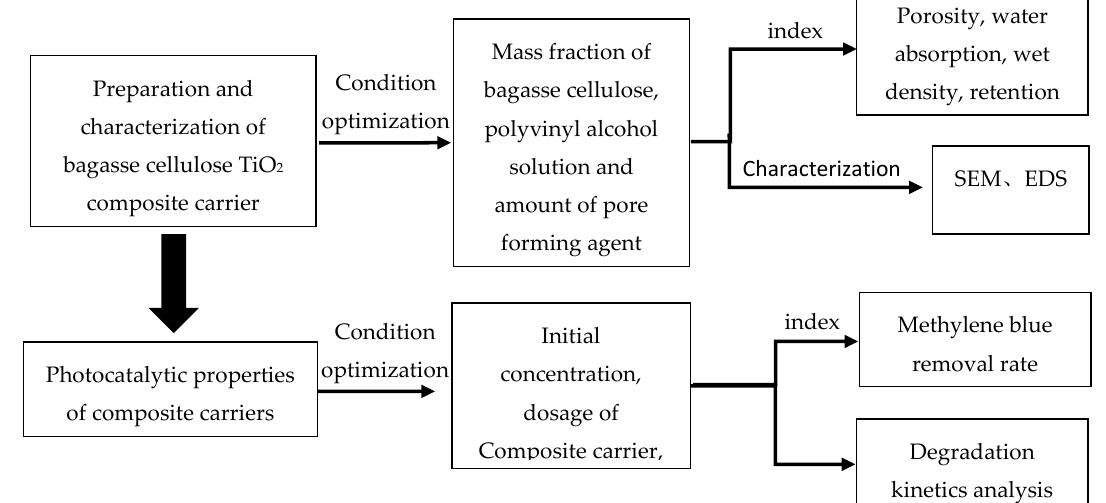
Figure 1. Flow chart of experiment.